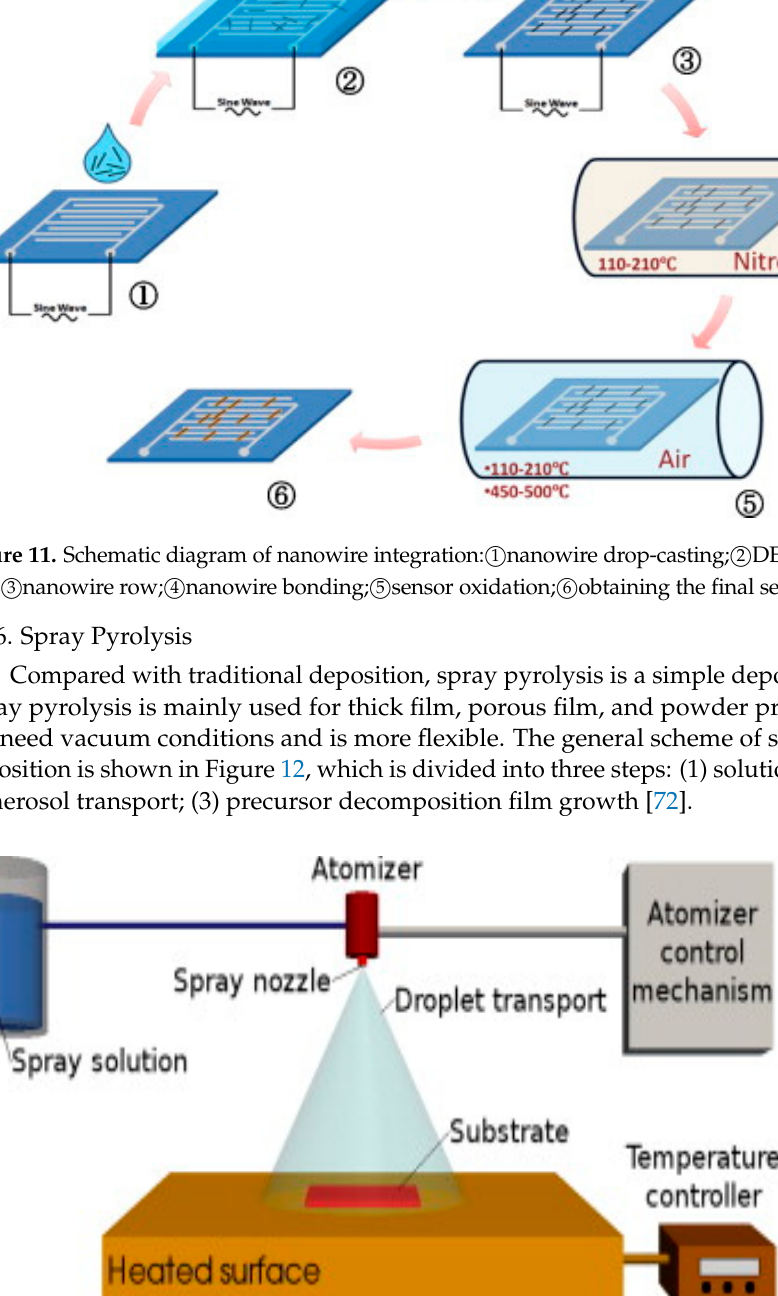
10 of 23 Figure 10. Assembly of nanowire on a micro-hotplate [55]. X. Li et al. successfully arranged indium oxide nanowires on interdigital microelec- trodes using dielectrophoresis, and the process is shown in Figure 11. First, the nanowires were added to ethanol and sonicated for 3 min. Then, transfer the nanowire suspension to a micro-hotplate using a pipette. The FG502 function generator was connected to the electrode of the micro-hotplate to generate an electric field, and a 6 V, 5 MHz sine wave